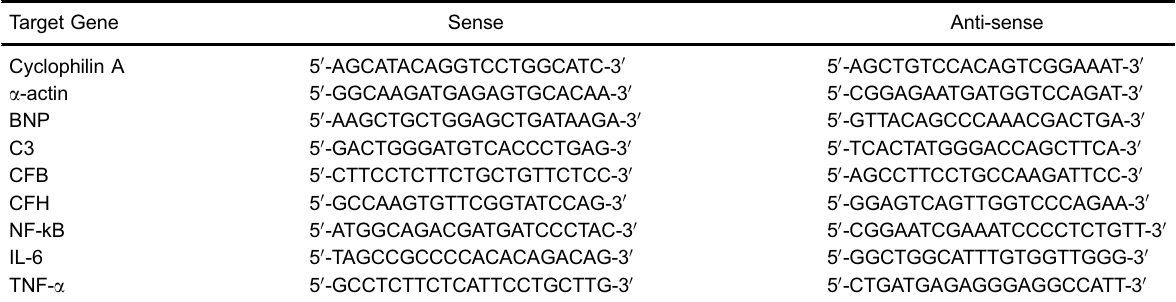
Table 1. List of primers.